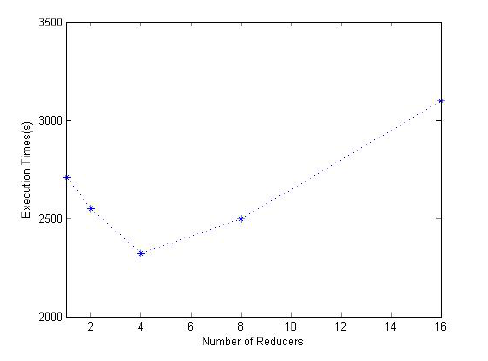
Figure 3. Executing times under different number of